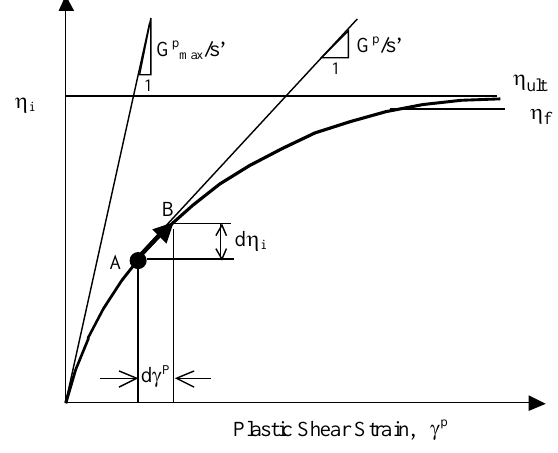
Figure 3. Hardening rule of the UBCSAND2 model.